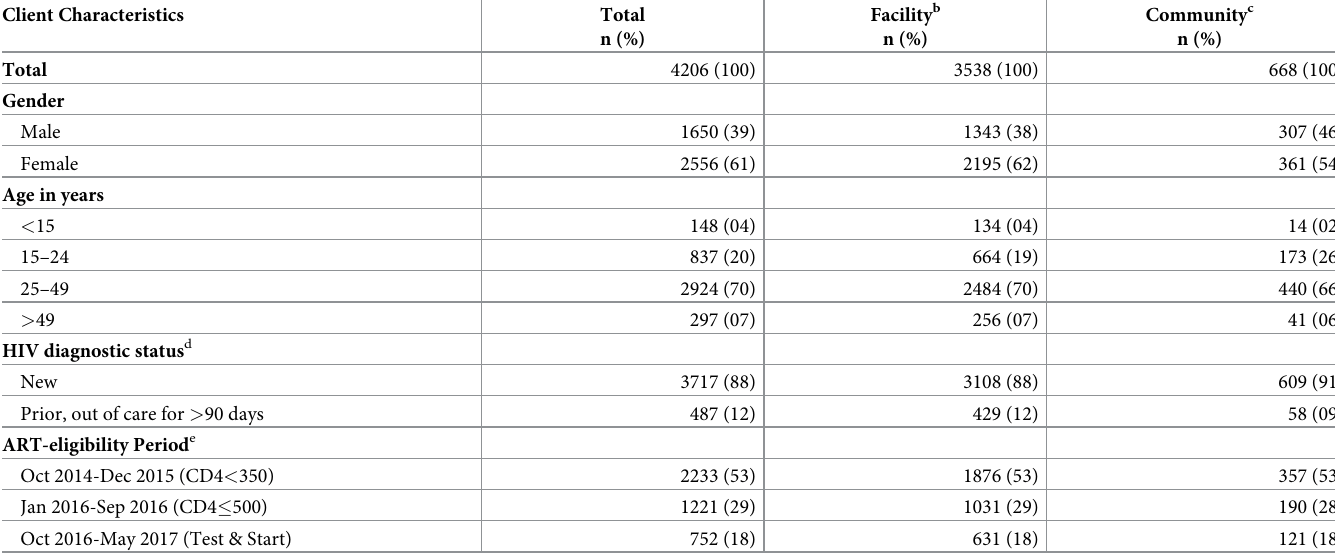
Table 1. LCM client characteristics, by setting of HIV diagnosis, Bukoba Combination Prevention Evaluation, Bukoba Tanzania, 2014–2017. a . Client